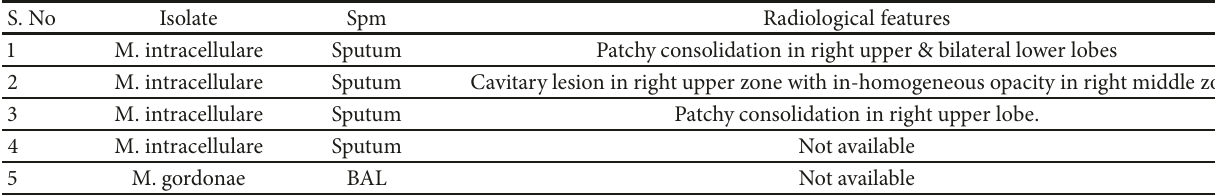
Table 2: Radiological features of patients with NTM isolates from